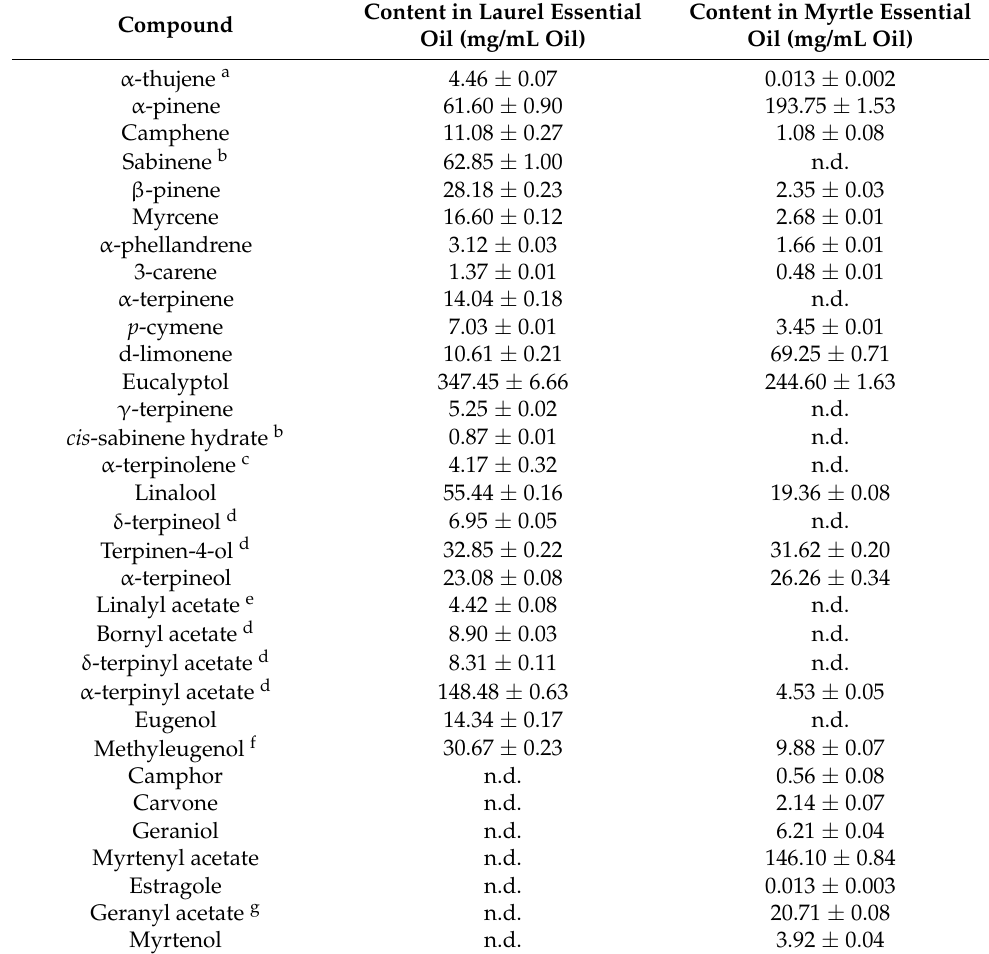
Table 2. Content and composition of volatile compounds in laurel and myrtle essential oil